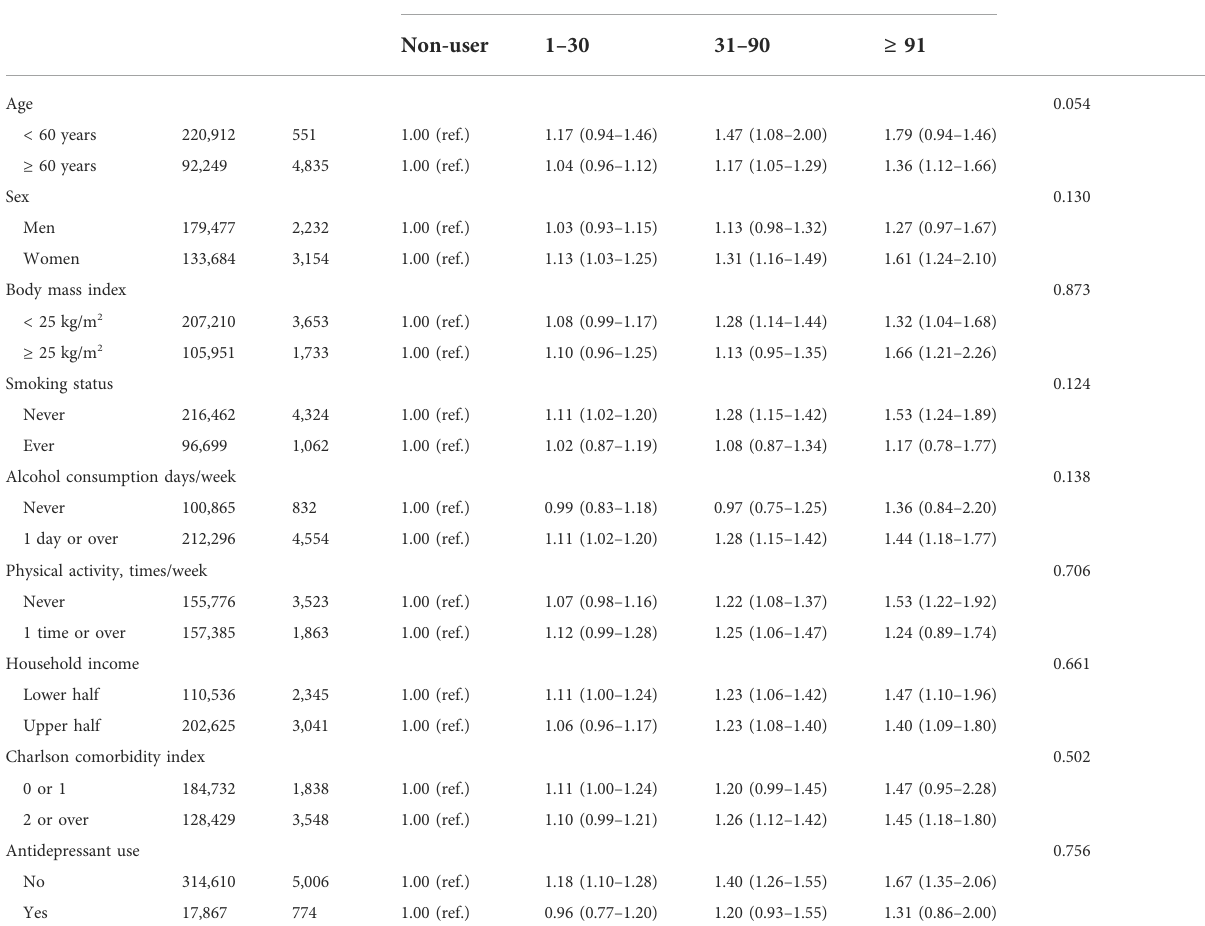
TABLE 2 Strati fi ed analyses of the association between antibiotic exposure and overall dementia